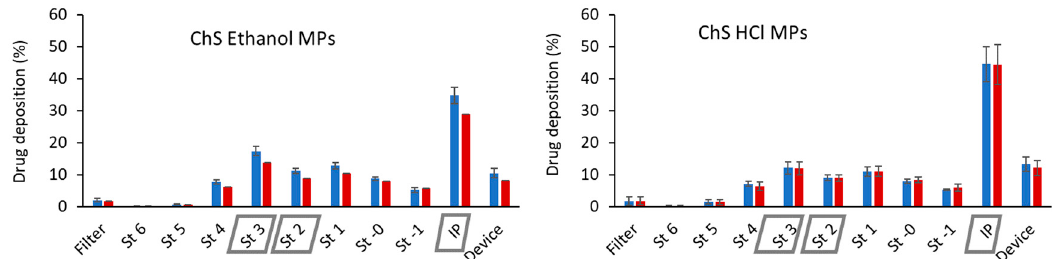
Figure 2. Stage-by-stage deposition profiles of isoniazid (blue) and rifabutin (red) inside the Andersen cascade impactor after aerosolisation of chondroitin sulphate (ChS) microparticles (MPs) with RS01 high resistance inhaler operated at 60 L / min (values are mean ± SD, n = 3). Grey boxes in the x -axis represent p < 0.05 comparing the same stage between the two formulations. IP: induction port; St: stage.